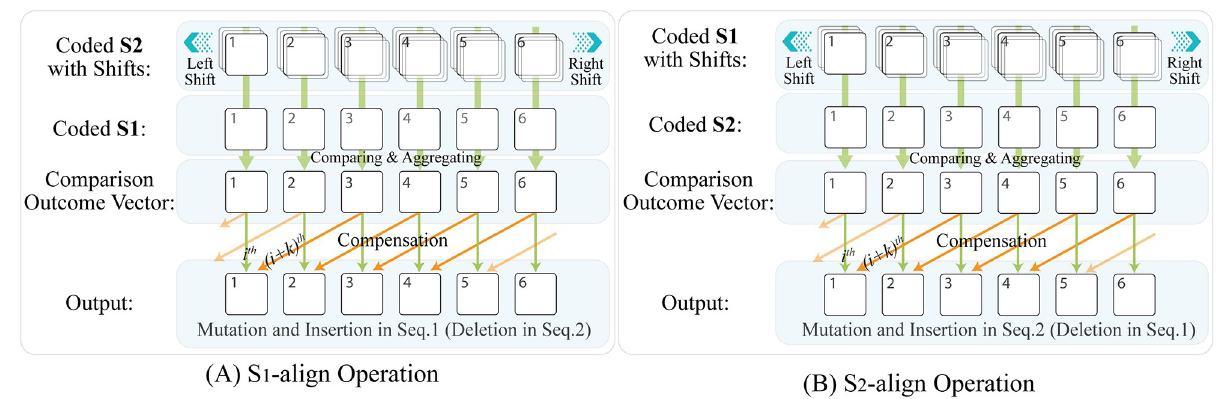
Fig 4. Side-by-side representation of the S 1 -align and S 2 -align operations of the HELIOS method. (A) As an overall view, the S 1 -align operation locates character substitutions, as well as character insertions in S 1 (or character deletions from S 2 ). For this purpose, it compares the main and all shifted S 2 vectors with the S 1 vector. Afterward, to produce the 1D output vector, the i th entry of the output is determined according to the i th and ( i + k ) th entries of the comparison outcome vector. (B) Similarly, the S 2 -align operation compares the main and all shifted S 1 vectors with the S 2 vector to locate character substitutions, as well as character insertions in S 2 (i.e. character deletions from S 1 ).